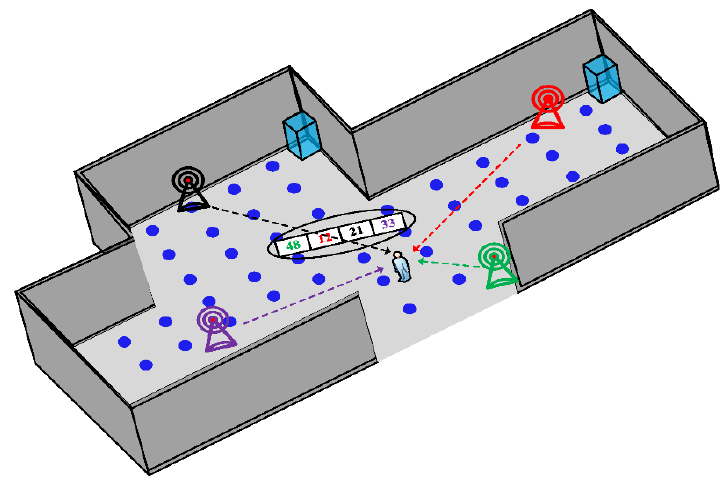
Figure 1. The working process of Wi-Fi fingerprinting indoor localization. A comparison of collected fingerprints in the database helps to estimate the locations of different clients (reproduced under the terms and conditions of the Creative Commons Attribution (CC BY) license from [43]).